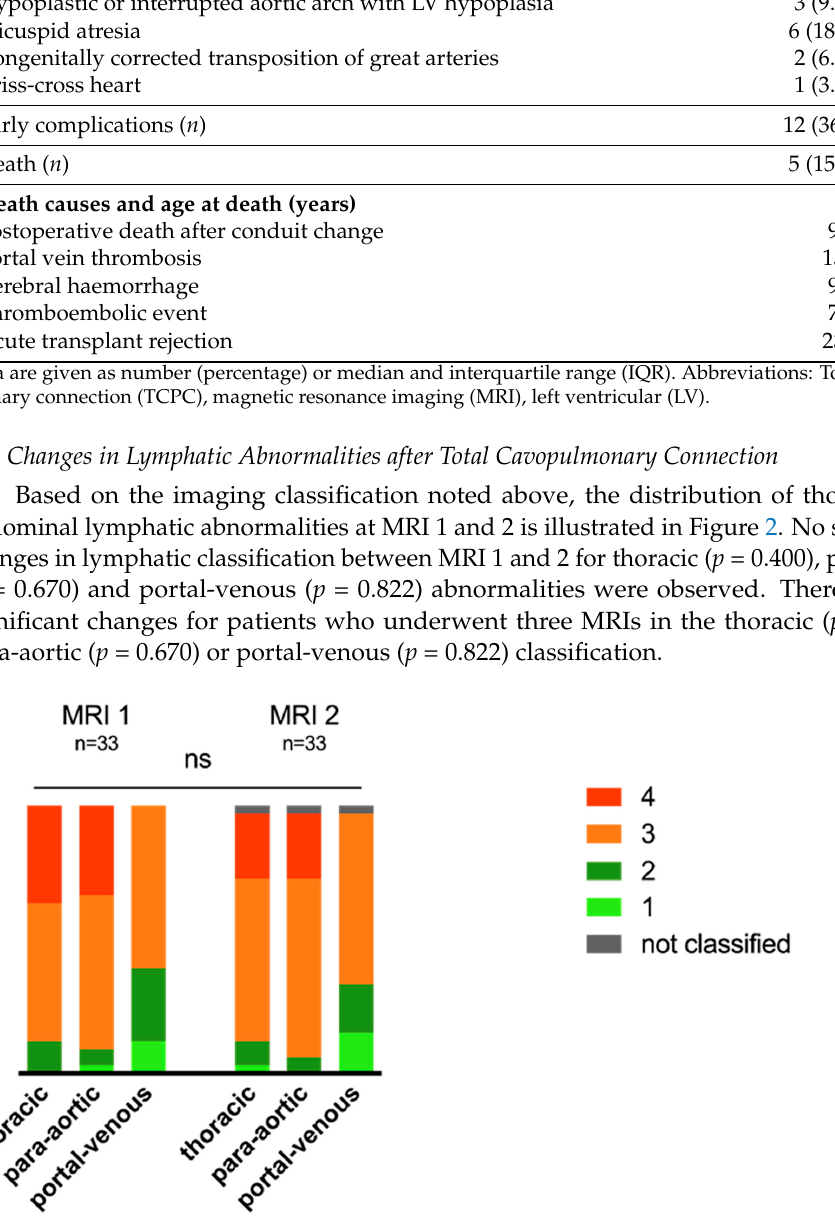
Figure 2. Changes in classification for thoracic and abdominal lymphatic congestion in MRI 1 and 2. Stacked bar graph illustrating distribution of lymphatic classification: light green type 1, dark green type 2, orange type 3, red type 4 and grey not classified. Thirty-three patients underwent two MRIs. There were no significant changes in lymphatic classification between MRI 1 and 2 (not significant = ns).